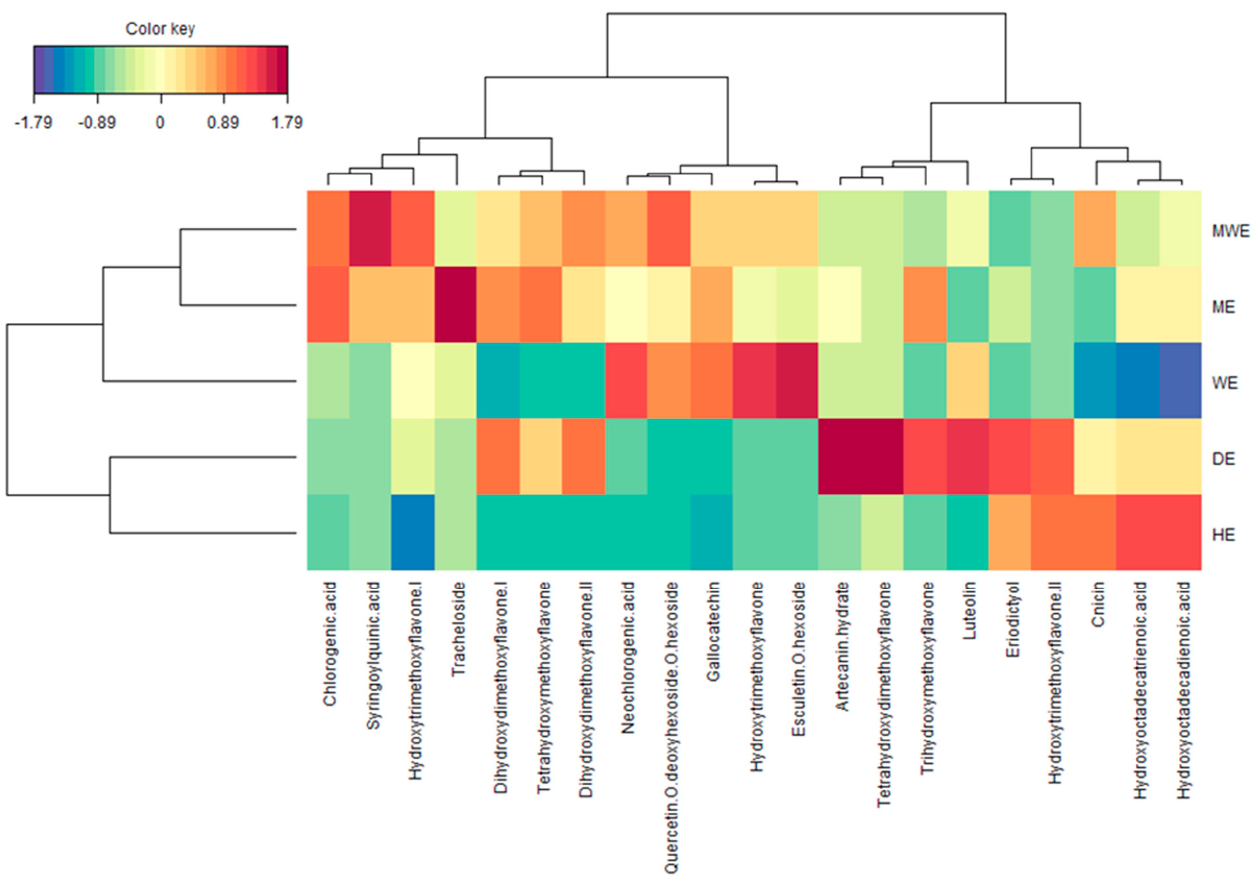
Figure 3. Clustered image map (red color: high content; blue color: low content) on the phytochemical dataset of the A. campestris subsp. lednicensis aerial part extracts.